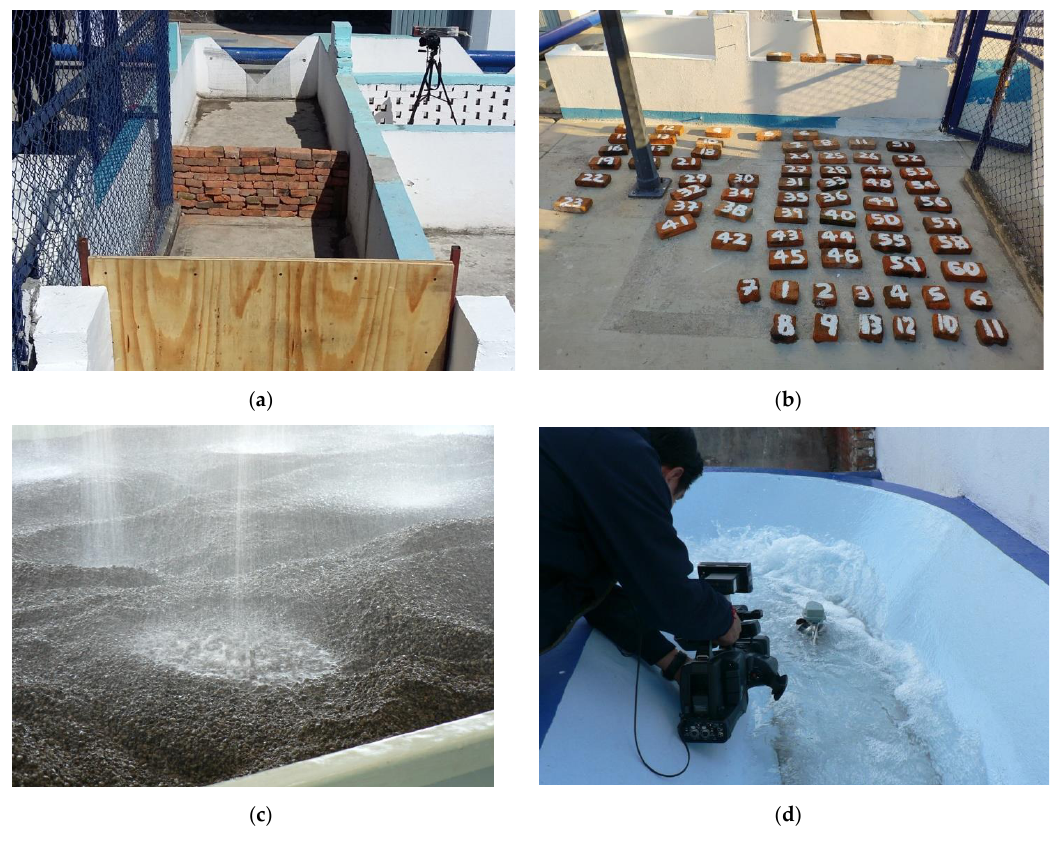
Figure 8. Examples of laboratory work: ( a ) Forensic hydraulics channel with an instantaneous opening gate; ( b ) brick setting for the construction of a brick-wall inside a simulation channel; ( c ) soil erosion simulator; and ( d ) flow velocity and turbulence meter in river and channel curves.